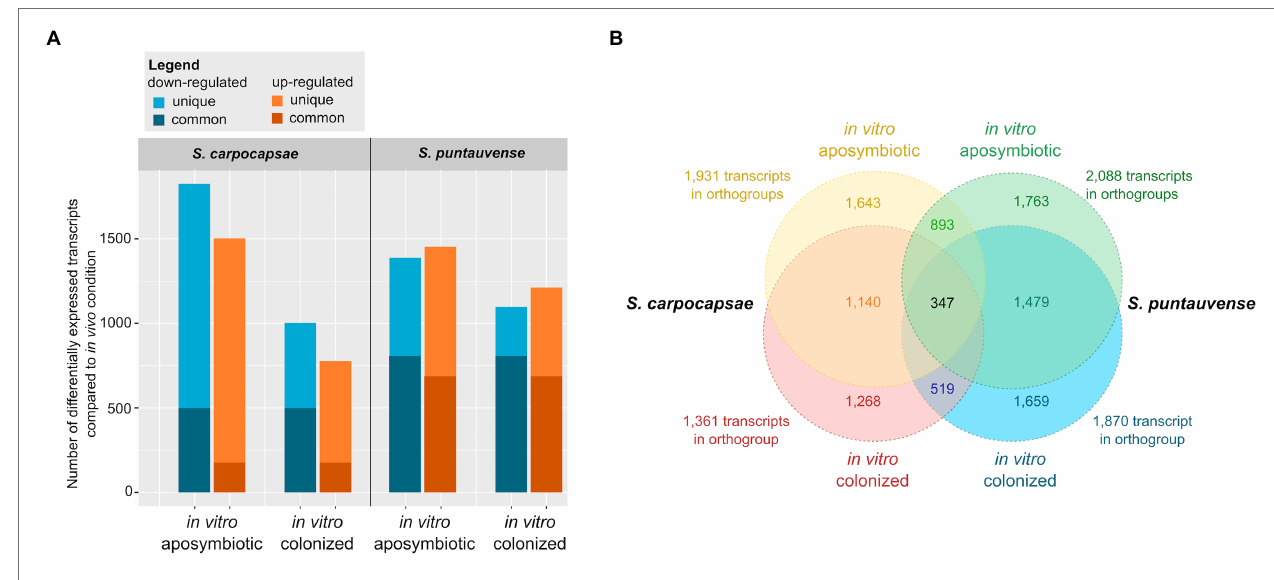
FIGURE 1 | Summary of differentially expressed transcripts in in vitro reared (colonized and aposymbiotic) Steinernema IJs compared to in vivo reared Steinernema IJs. (A) Graph of transcripts number associated with significant downregulation or upregulation in the in vitro condition (colonized or aposymbiotic) were compared to the in vivo rearing condition. The differential expression was established using cufflink and/or edgeR. (B) Venn diagrams of orthogroups of differentially expressed transcripts shared among the in vitro colonized and in vitro aposymbiotic nematodes for the two Steinernema species. The orthogroups were identified with